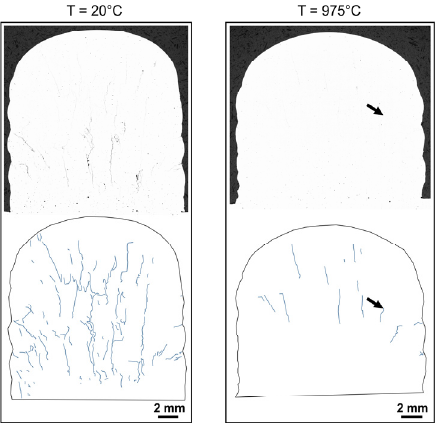
Figure 6. Polished cross-sections ( top ) and crack visualization ( bottom ) for cubes with 15 mm edge length fabricated without ( left ) and with ( right ) laser preheating to increase the initial substrate temperature T. The arrows show the location of an exemplary crack that is illustrated at higher magnification in the following figure.